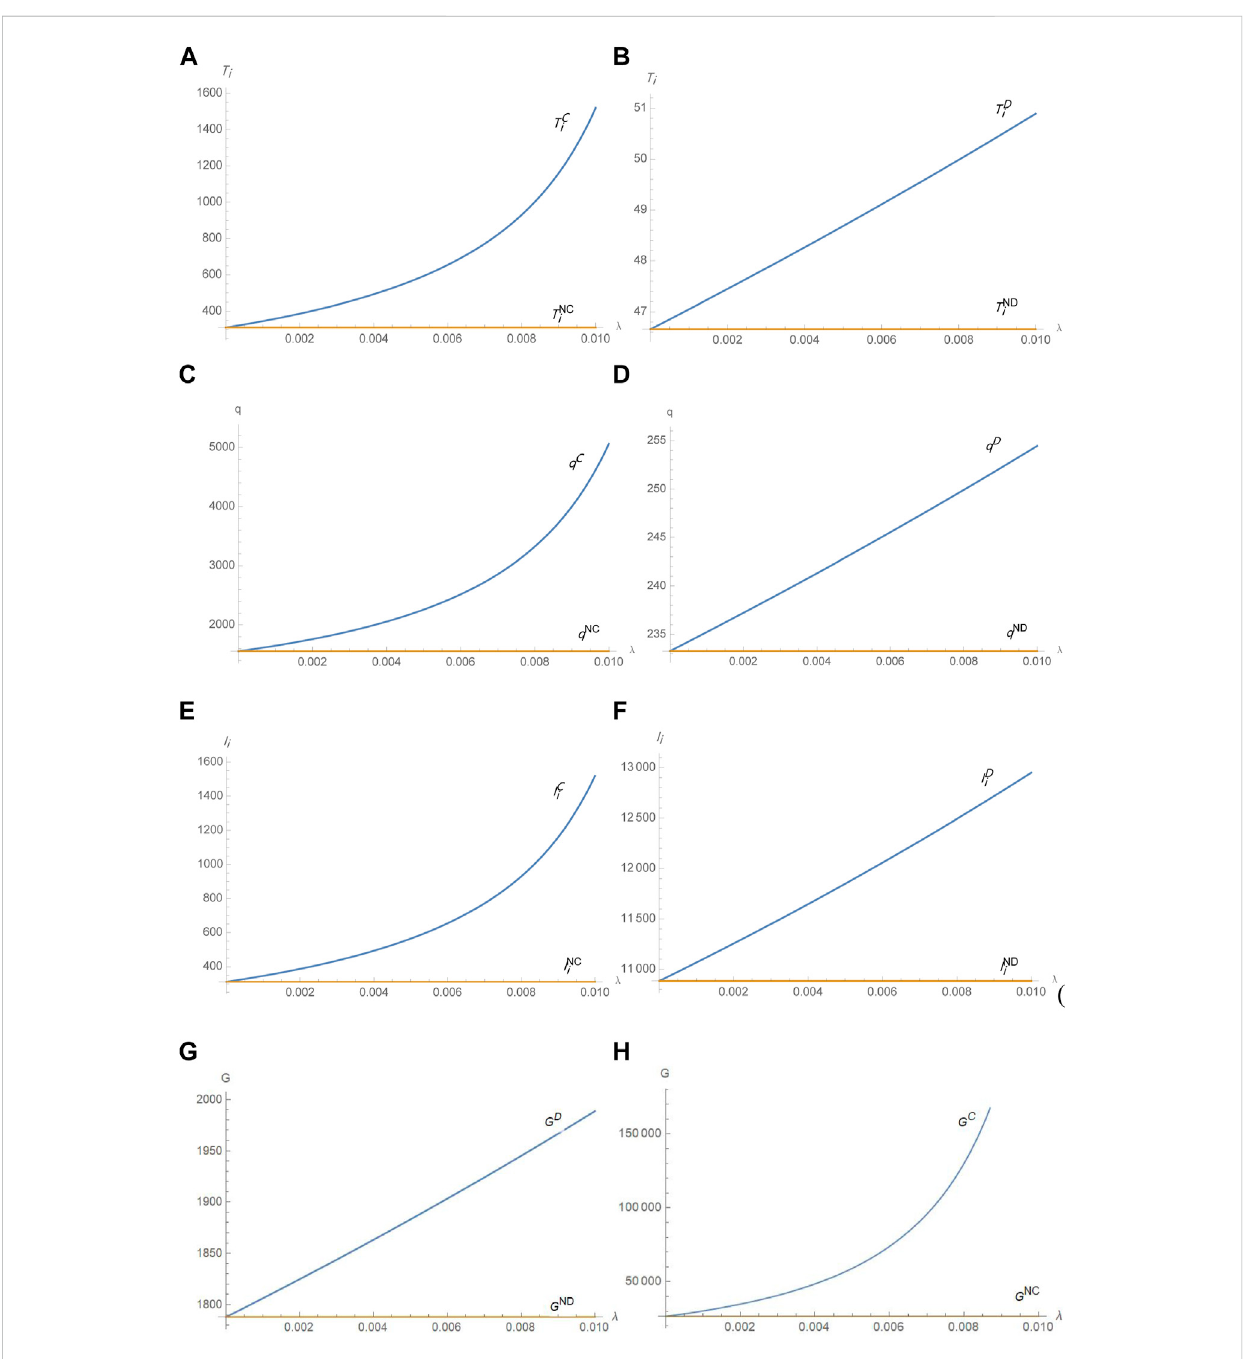
FIGURE 1 Impact of the technological innovation credit coef fi cient on the optimal